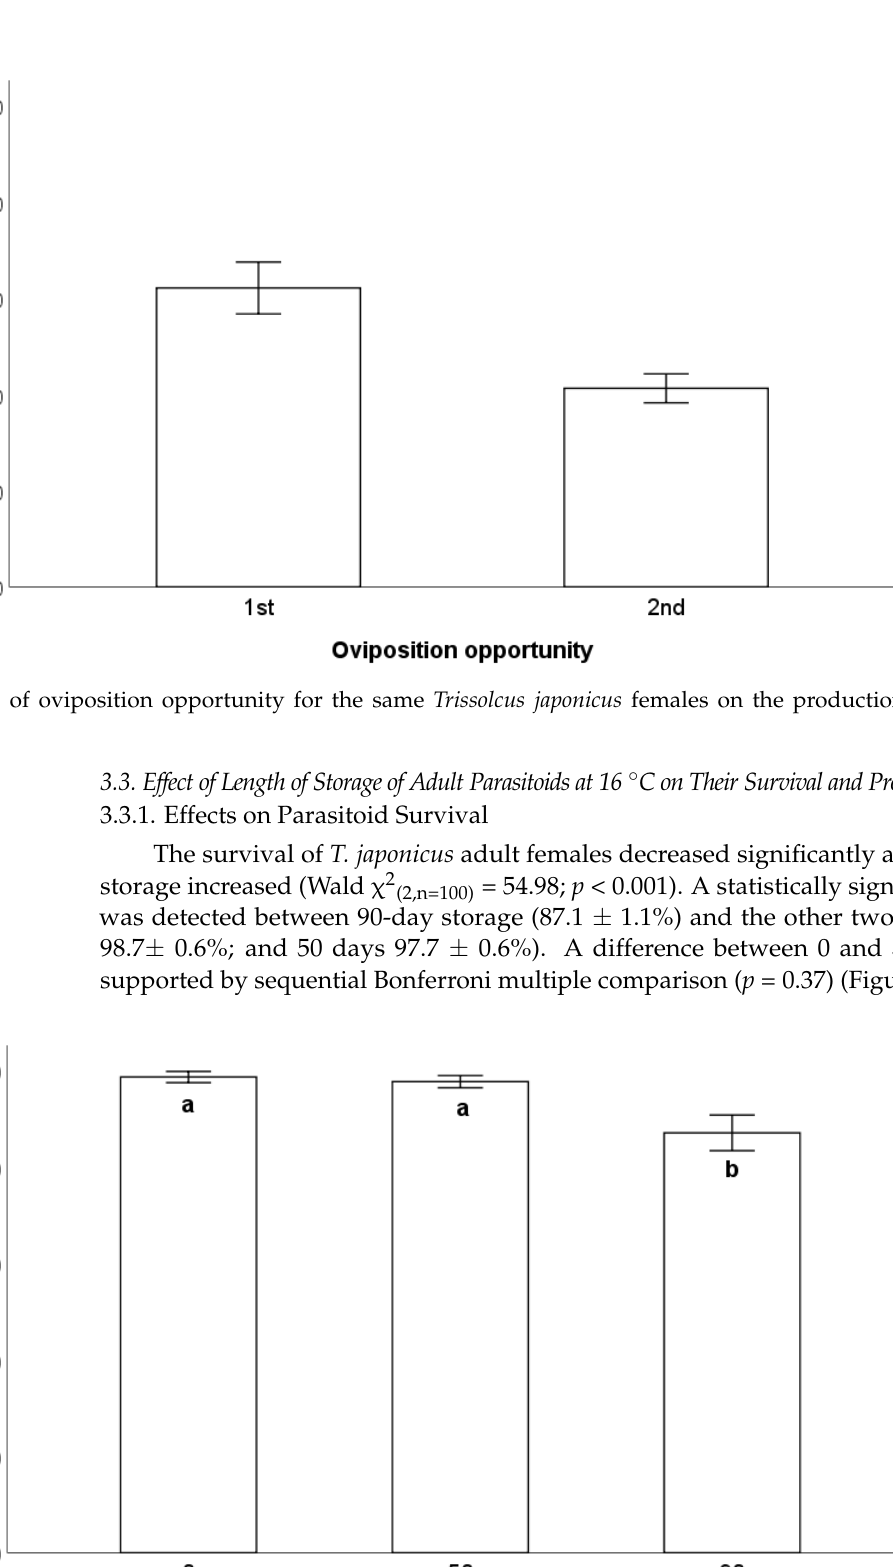
Figure 4. Effects of exposure time of an egg mass (stored prior to exposure at 6 °C for 28–50 days) to a single Trissolcus japonicus female on the production of progeny (GLM, p < 0.05). Different letters indicate significant differences ( p < 0.05) as detected by multiple comparison with sequential Bonferroni adjustment.